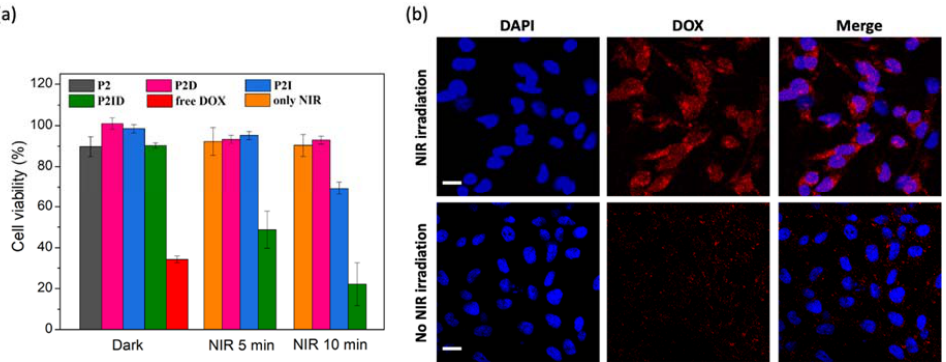
Figure 6. ( a ) Cell viability of HeLa cells treated with various nanofibers and free DOX in the absence and presence of NIR irradiation (0.47 W/cm 2 ). ( b ) CLSM images of HeLa cells treated with P2ID nanofibers with or without NIR irradiation (0.47 W/cm 2 , 10 min). The scale bar is 20 μ